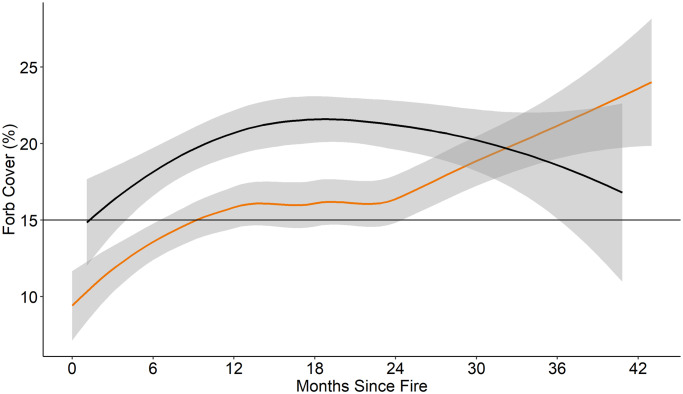
Percent forb cover.Percent forb cover for fire-only (orange) and pyric herbivory (black) treatments at all sites from 2014 to 2016. Shaded area indicates 95% confidence interval. Horizontal line represents minimum cover of forbs (15%) selected by females with broods as described in primary literature. *Regression lines and confidence intervals generated using “loess” locally-weighted smoothing function.